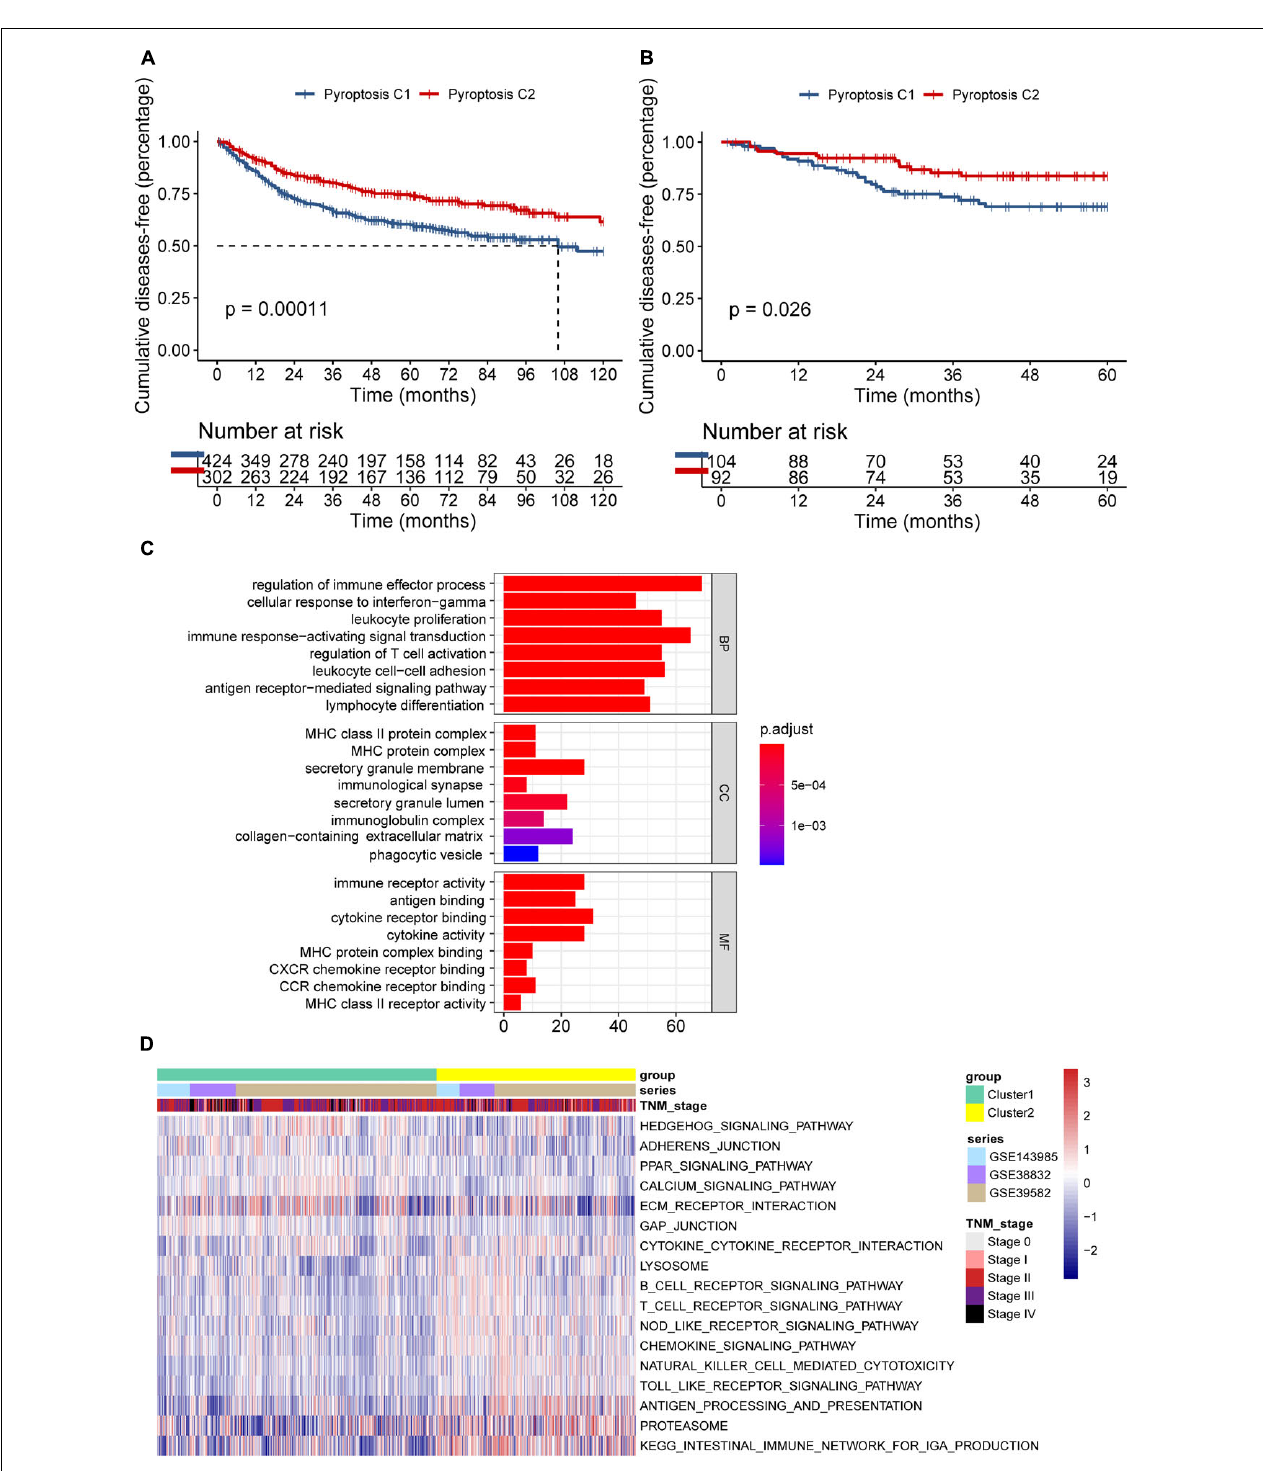
FIGURE 3 | Differences in the prognosis and biological characteristics between two clusters. (A) Kaplan–Meier curves showed significant survival differences between pyroptosis C1 and pyroptosis C2 based on 726 colon cancer patients from the meta-GEO (Gene Expression Omnibus) cohort ( p < 0.001). (B) Pyroptosis C2 also showed significantly better disease-free survival than did pyroptosis C1 in the GSE14333 cohort ( p = 0.026). (C) Functional annotation of the differentially expressed pyroptosis-related genes between C1 and C2 using Gene Ontology (GO) enrichment analysis in the meta-GEO cohort. (D) Enrichment analysis using gene set variation analysis (GSVA) showing the activated biological pathways in distinct pyroptosis-related gene (PYG)-mediated molecular patterns in the meta-GEO cohort. The red strip represents the activated pathways and the blue strip refers to the inhibited pathways. C1, cluster 1; C2, cluster 2.